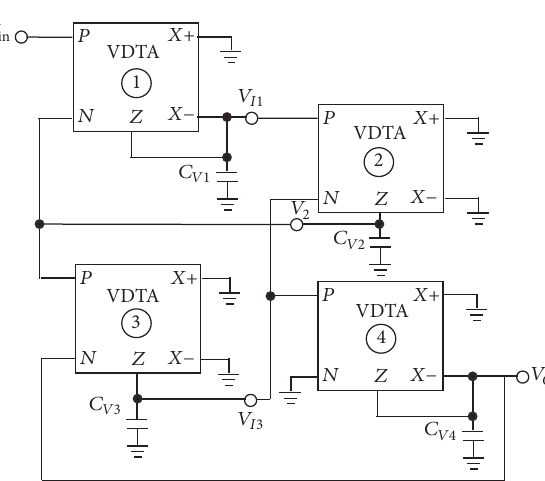
Figure 8: Simulated frequency response of 4th-order Butterworth low pass